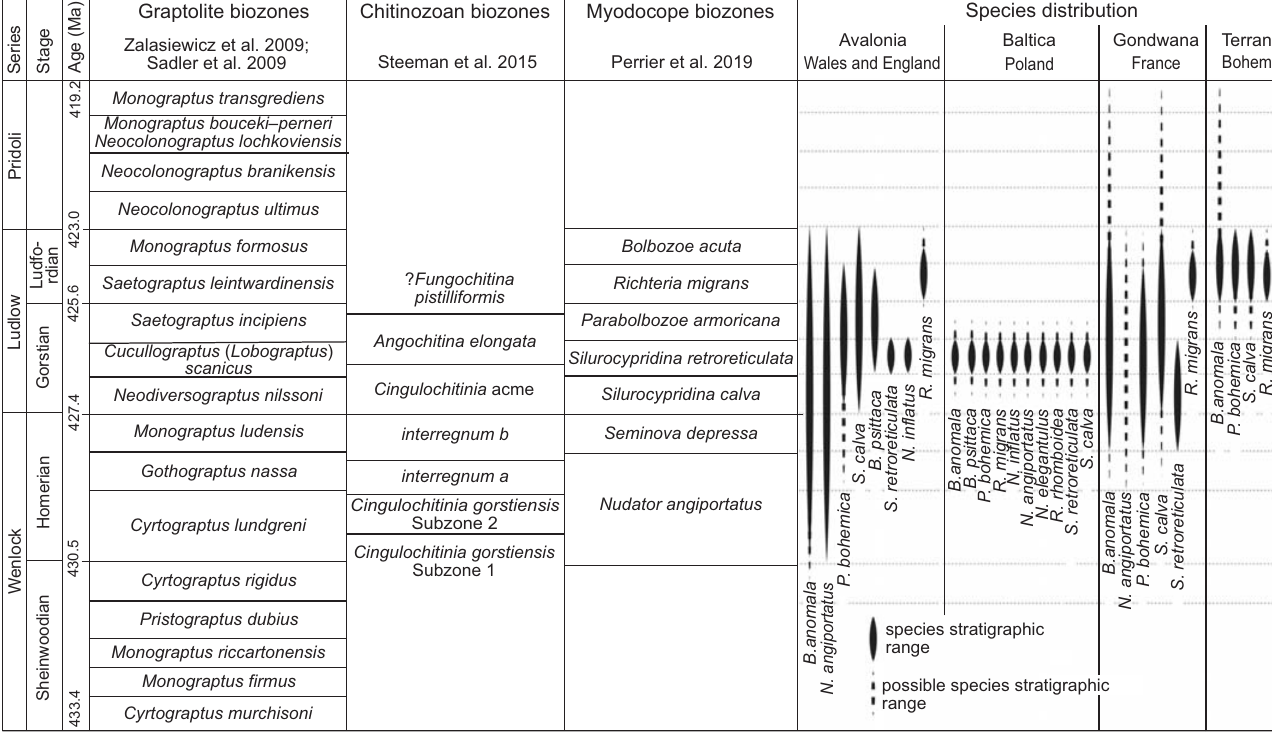
Fig. 9. Stratigraphical distribution of myodocope species in the Silurian of Poland compared to England, Wales, France, and Bohemia.